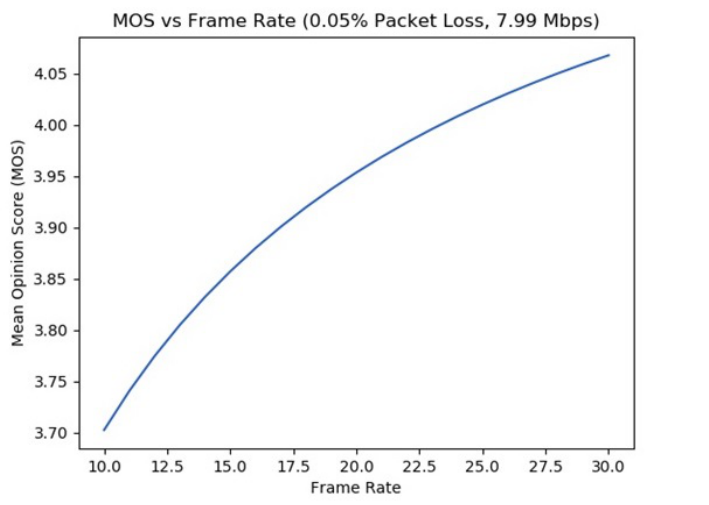
Figure 5. MOS with respect to frame rate (ITU-T Recommendation P.1070).